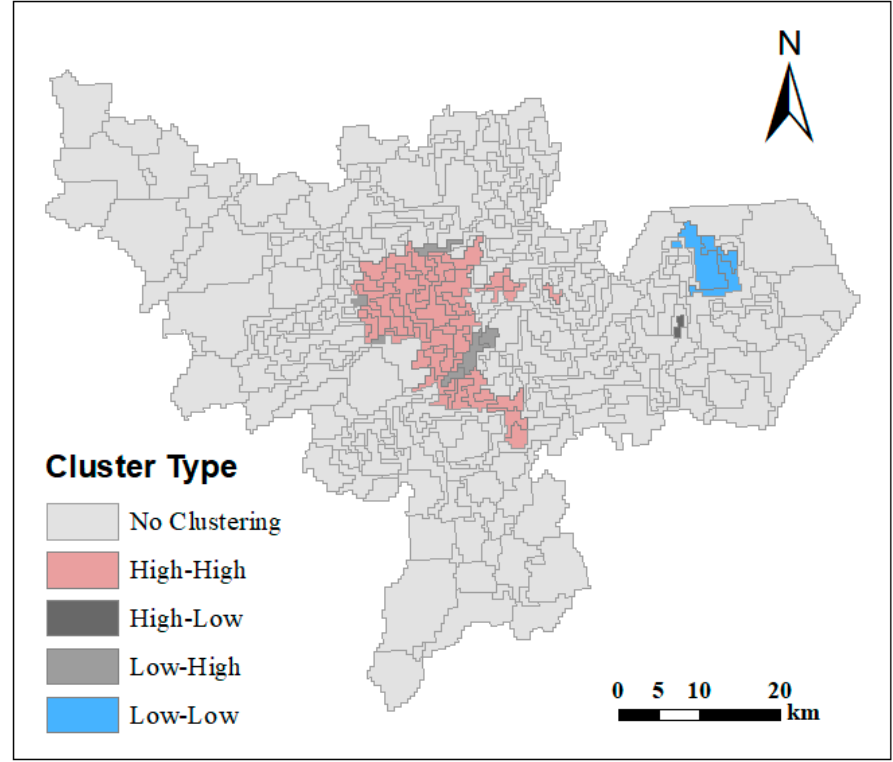
Figure 9. Four cluster types of the results of local spatial autocorrelation analysis for the POI densities in units.